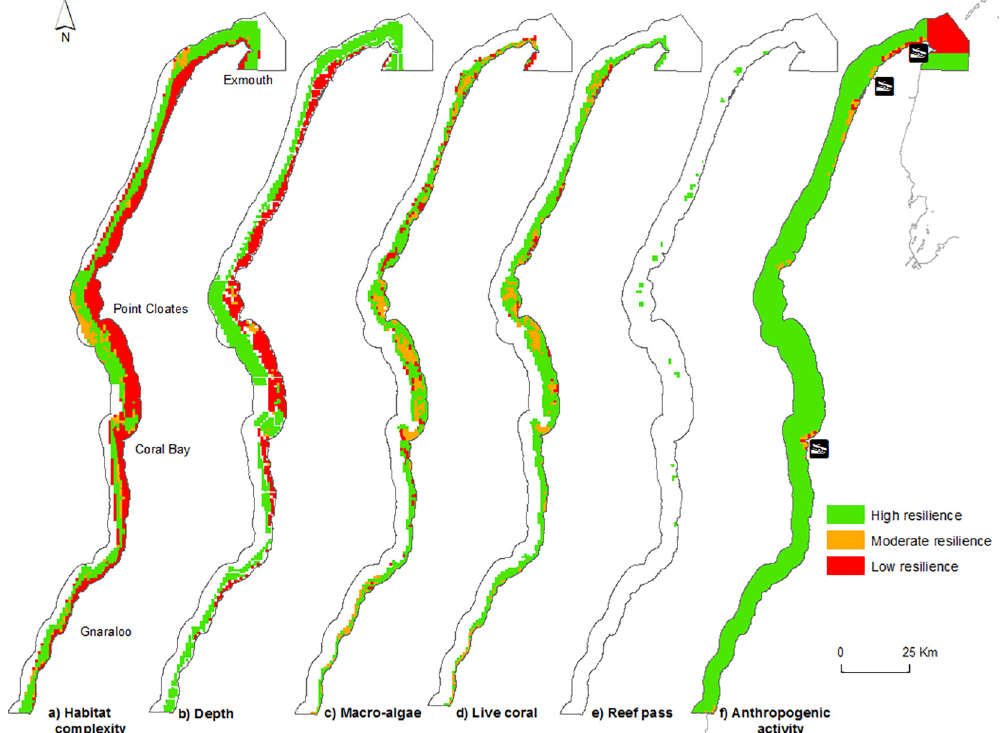
Fig 2. Spatial distribution of resilience features at Ningaloo Marine Park; a) Structural complexity, b) Depth, c) Live coral cover, d) Macro-algal cover, e) Reef passes (water mixing), f) Proximity to anthropogenic